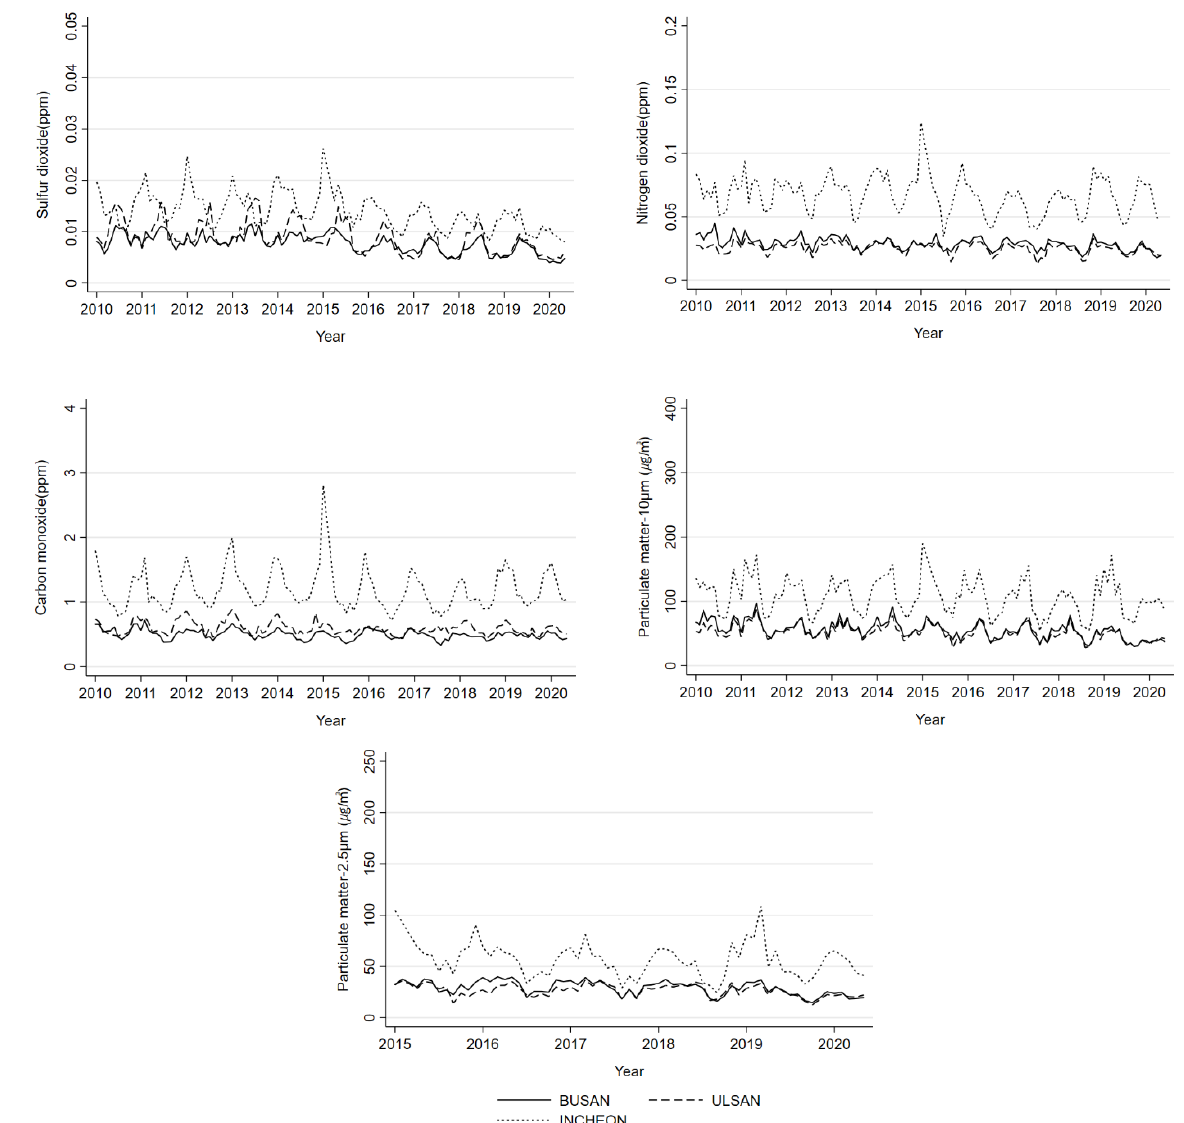
Figure 3. The monthly average level of air pollutants by port.